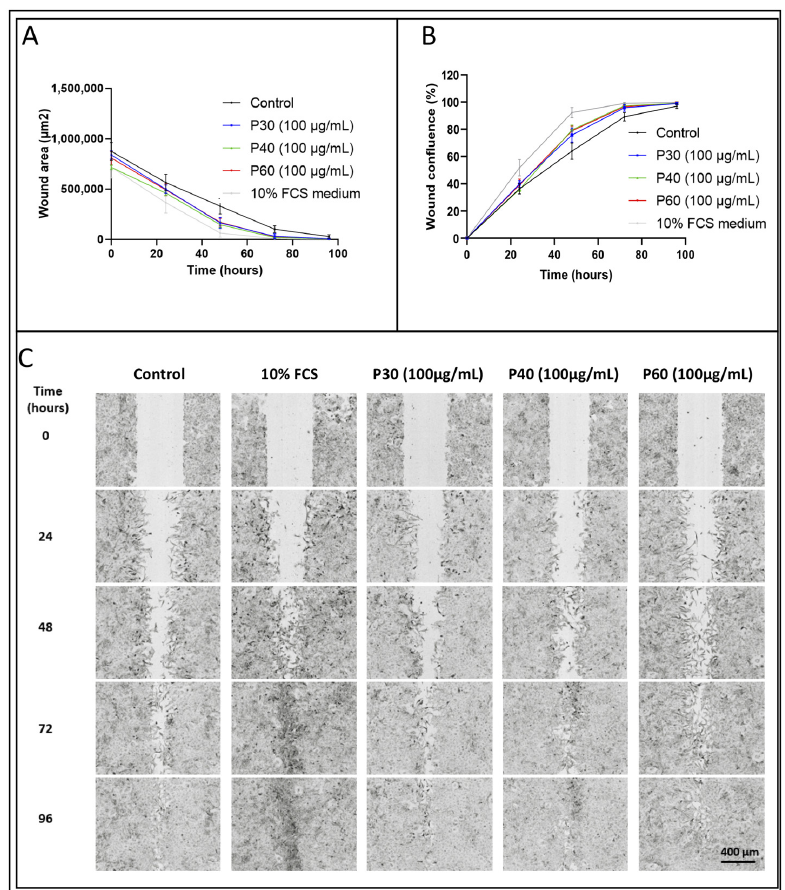
Figure 15. Wound-filling analysis following a scratch wound assay. Equine articular chondrocytes (eACs) were seeded at P2. At 90% of confluency, a scratch wound assay was performed using a WoundMaker TM kit (Essen BioScience) and then the treatments were added. eACs were incubated in the presence of a culture medium containing 2% fetal calf serum (FCS) (Control), and P30, P40, or P60 at 100 µ g/mL. The cells were also incubated in the presence of 10% FCS. The wound areas ( A ) were monitored until 96 h of incubation, and the wound confluences ( B ) were calculated using the ImageJ software. Every 24 h, photographs ( C ) of the wound were taken with Incucyte. The significance of the values between the different treatments and the control case was tested using a two-way ANOVA followed by Bonferroni test for multiple comparisons ( n = 4). P30, P40 and P60: Promerim ® 30, Promerim ® 40, and Promerim ®